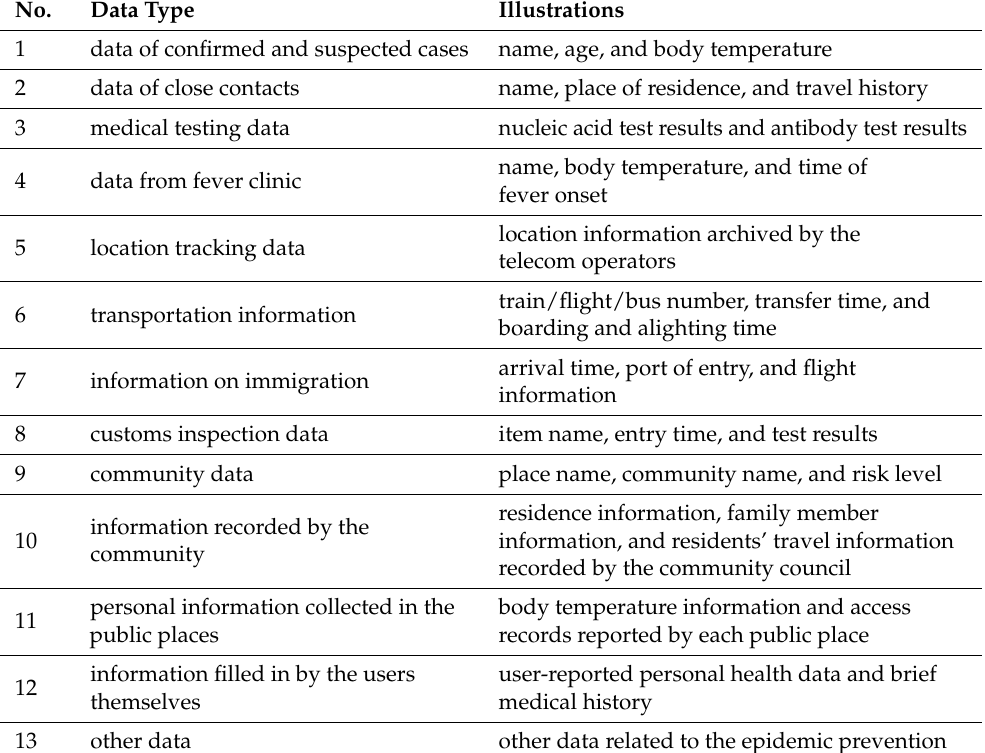
Table 1. Data that might be collected for generating a personal health